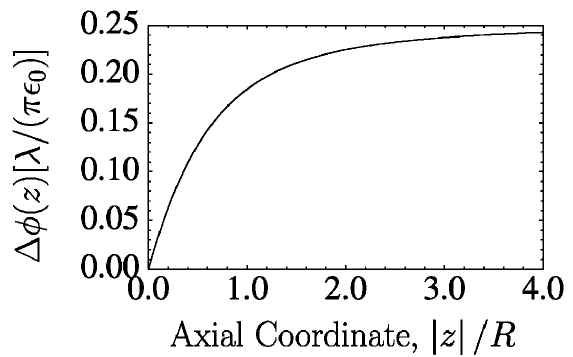
FIG. 4. Radial potential drop of a uniform density axisym- metric beam with radius R (cid:1) const near a conducting plate. The potential drop ! (cid:14) (cid:3) z (cid:4) (cid:1) (cid:14) (cid:3) r (cid:1) 0 ; z (cid:4) (cid:2) (cid:14) (cid:3) r (cid:1) R; z (cid:4) from beam center ( r (cid:1) 0 ) to edge ( r (cid:1) R ) is normalized by (cid:4) and plotted versus j z j =R . (cid:23)= (cid:3) (cid:24)(cid:18) 0